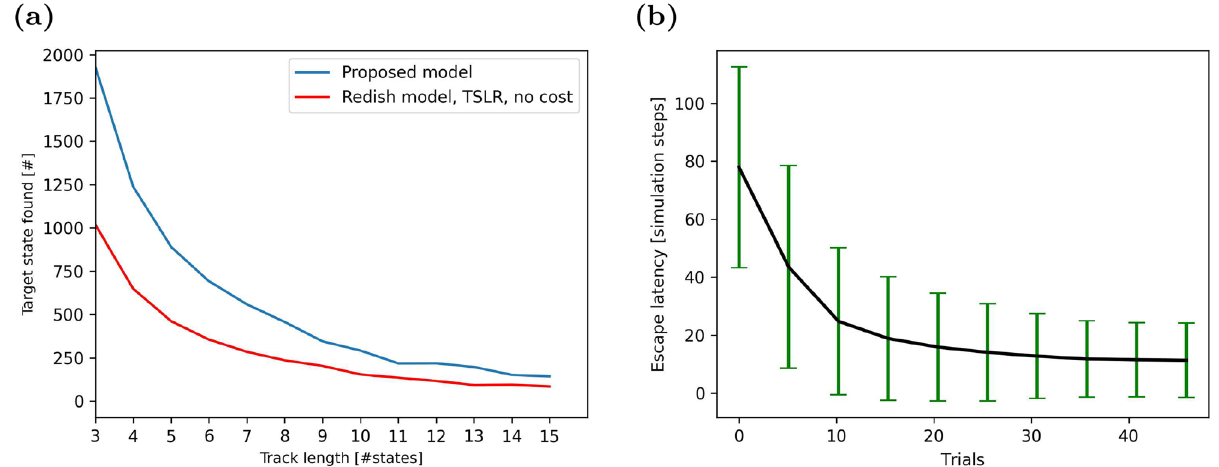
Figure 4. Performance on spatial navigation tasks. ( a ) Number of times the agent finds the goal location given a total of 5000 simulation steps on a linear track in our model (blue line) and comparison model 17 (red line). Results are averaged over 50 simulations for each track length. ( b ) Escape latency in the virtual watermaze decreases with learning trials. Data averaged over 1000 agents, error bars represent standard